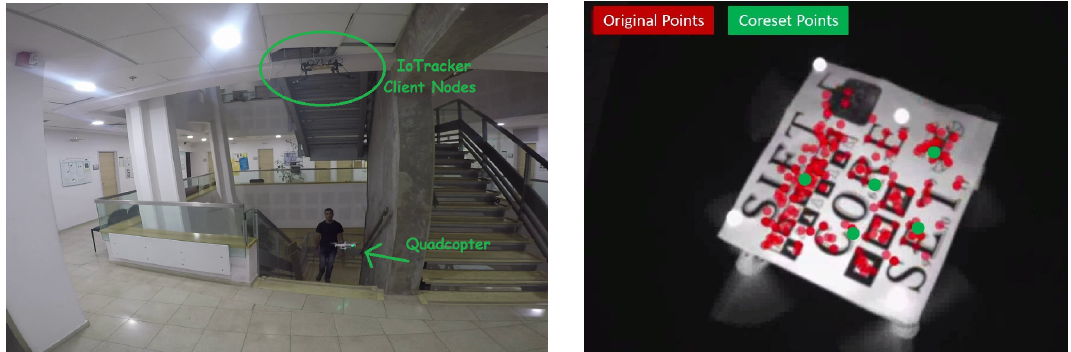
Figure 1. Snapshots from the companion video in: [30]. ( Left ) “Guardian Angle” system. A safe and low-cost quadcopter autonomously leads a guest to its destination ( Right ) “real-time computation of the Kabsch-Coreset. A set P of | P | = n interest points detected on a planar pattern placed on a drone (red points). A subset (coreset) C ⊆ P of | C | = 5 points (green points). It is guaranteed that the pose of the drone when computed using the weighted coreset C will be the same as the pose computed from the whole set P